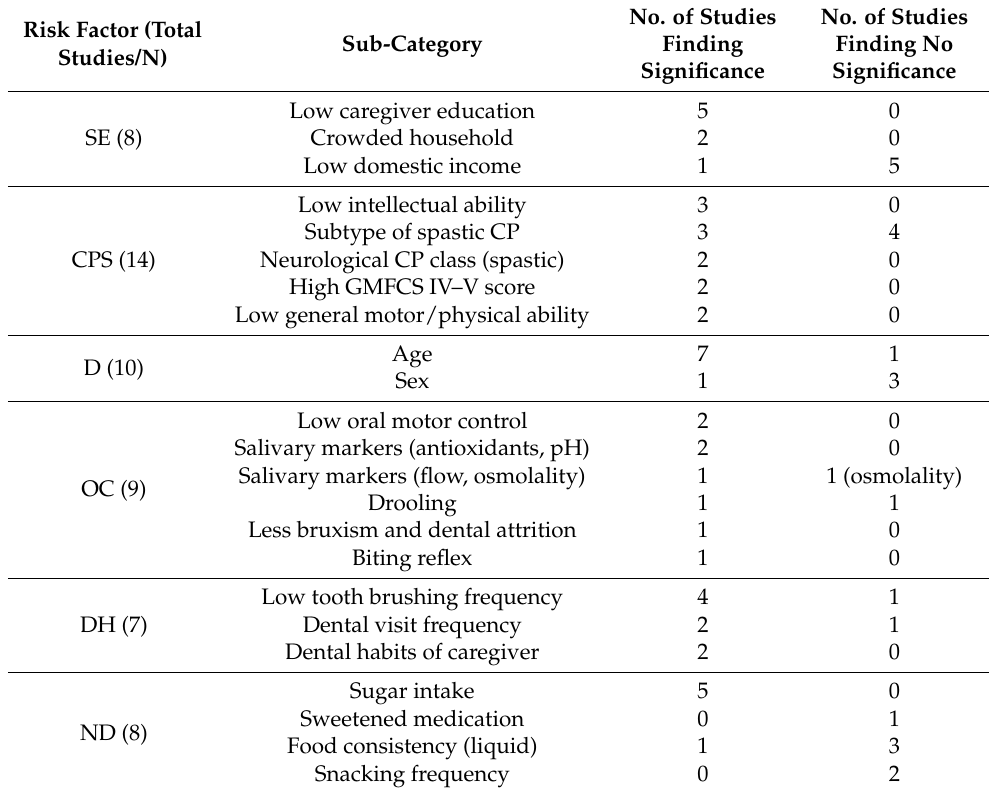
Table 2. Quantification of significance and non-significance found for six risk factors and their respective sub-categories (N = 30) Socioeconomic factors (SE), Cerebral Palsy Subtype (CPS), Demo- graphics (D), Condition of Oral Cavity (OC), Dental Habits (DH) and Nutrition and Diet